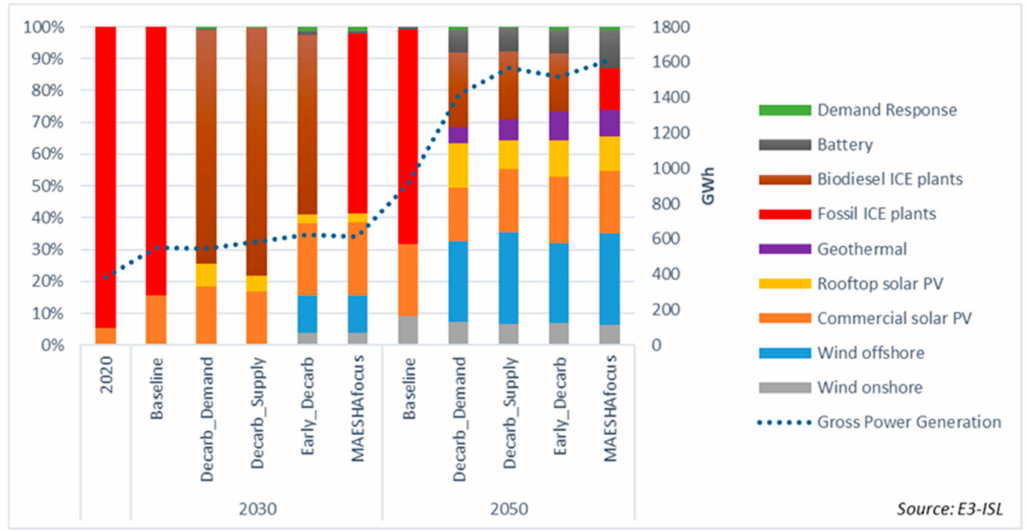
Figure 9. Gross power generation by plant type and scenario in 2030 and